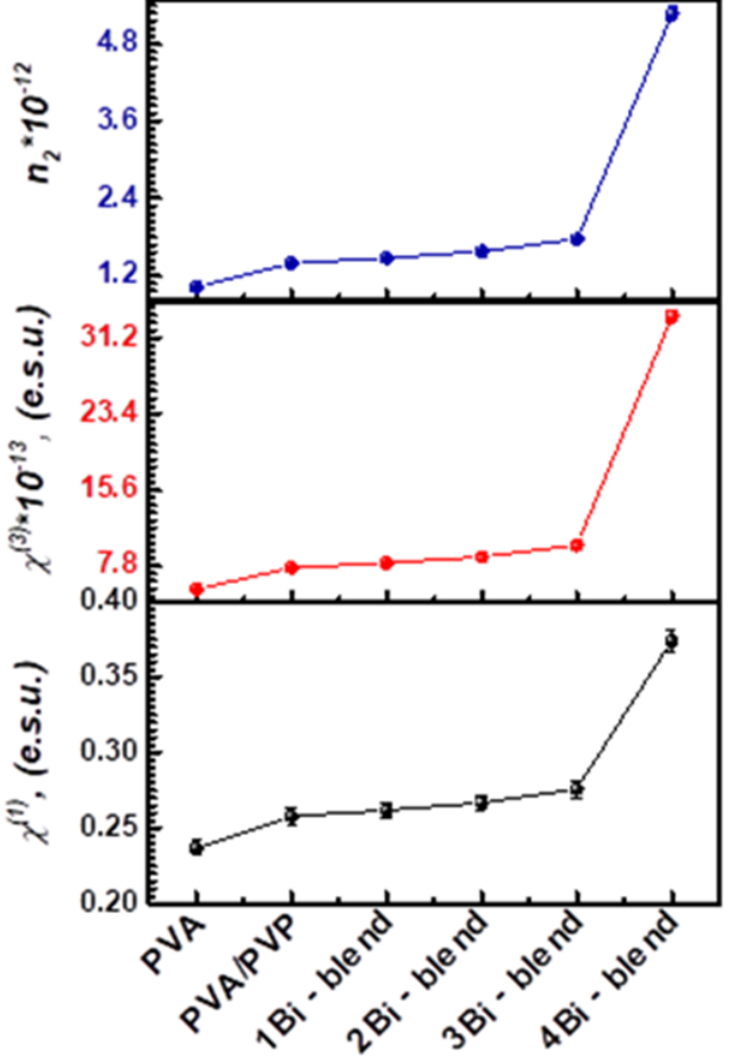
Figure 13. Non-linear optical parameters χ ( 1 ) , χ ( 3 ) , and n 2 for pristine PVA, PVA/PVP blend, and Bi-blend hybrid films